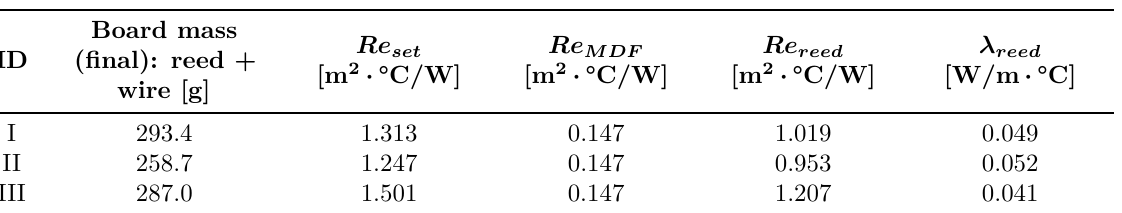
Table 2. Characteristics of the reed board prototypes.